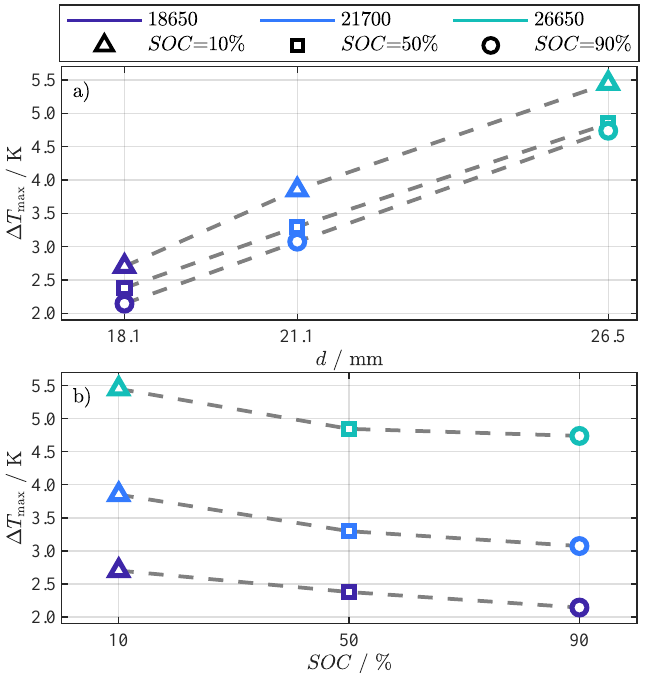
Figure 6. Relation between the maximum of the R Figure 5 and cell diameter d ( a ), respectively SOC ( b